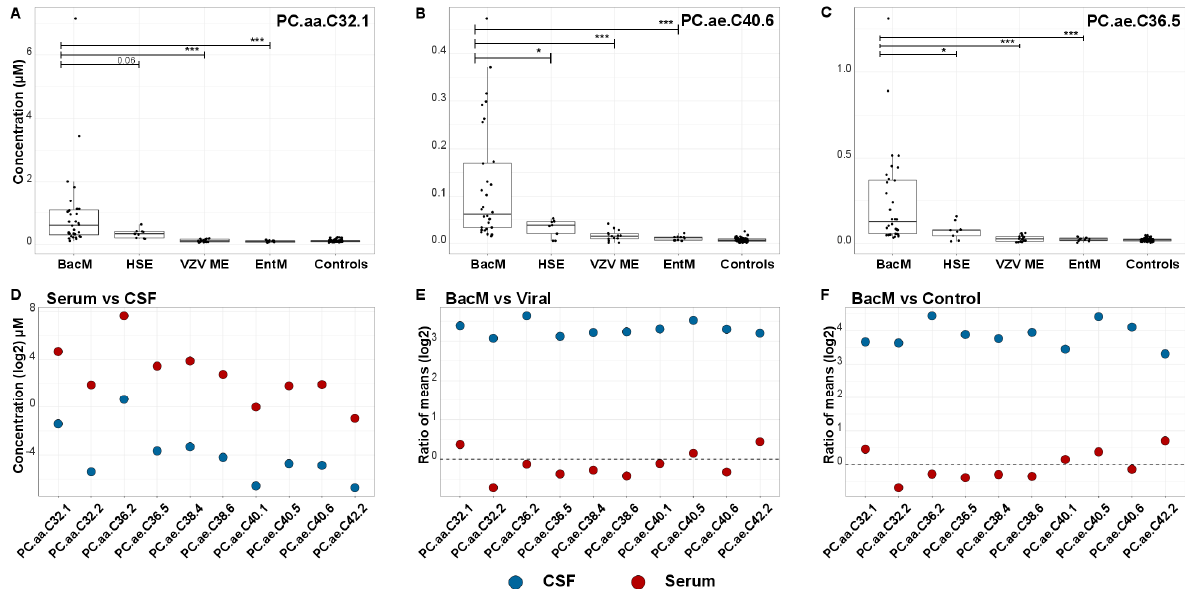
Figure 4. Concentrations of phosphatidylcholine biomarkers in bacterial and viral CNS infections and noninflamed controls. ( A – C ). CSF concentrations of the three best validated markers in bacterial meningitis, viral CNS infections (all), HSV encephalitis, VZV meningoencephalitis, enterovirus meningitis, and controls. ( A ) PC.aa.C32.1. ( B ) PC.ae.C40.6. ( C ) PC.ae.C36.5. ( D – F ). Comparison of CSF vs. serum concentrations of the 10 most robust metabolite biomarkers in the eight bacterial meningitis cases in which paired CSF-serum samples were available. ( D ) Mean CSF (blue) and serum (brown) concentrations. ( E , F ). Ratios of mean concentrations of the 10 phosphatidylcholine biomarkers in bacterial meningitis/controls ( E ) and bacterial meningitis/viral CNS infections ( F ) in CSF (blue) and serum (brown). * p ≤ 0.05, *** p ≤ 0.001.